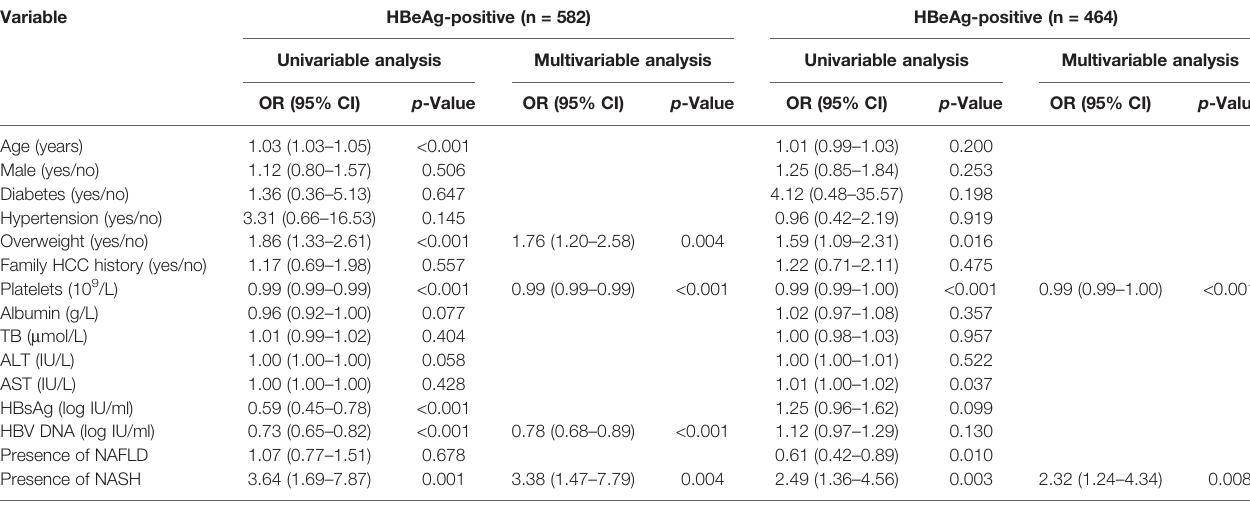
TABLE 5 | Univariable analyses and multivariable analyses of factors associated with signi fi cant fi brosis in HBeAg-positive and HBeAg-positive subgroups. Variable